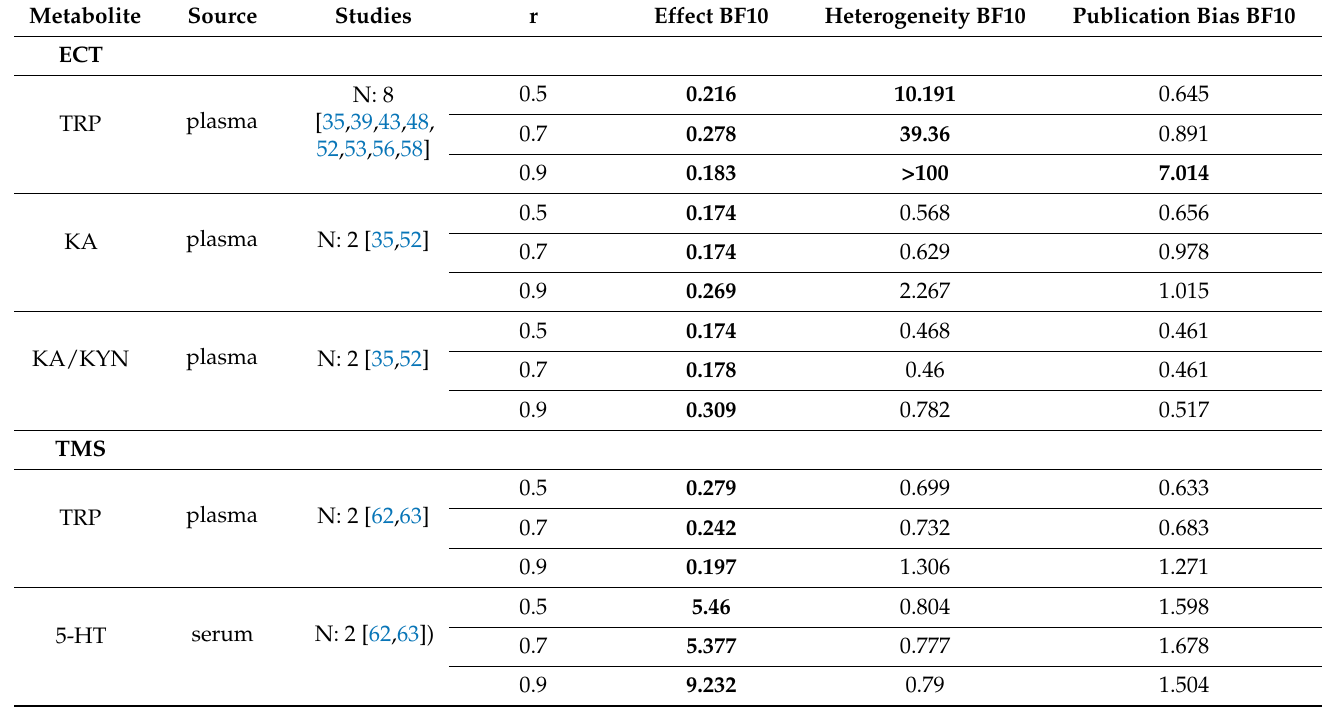
Table 4. Outcomes of robust Bayesian